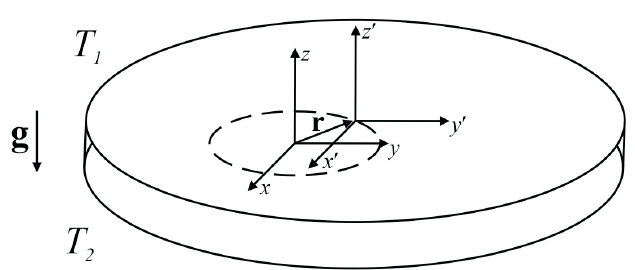
Figure 1. The problem